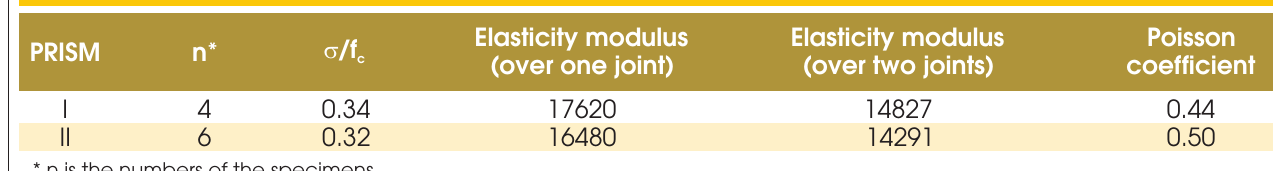
Table 7 – Elasticity modulus and Poisson ratio for the prisms with vertical joints (type B)